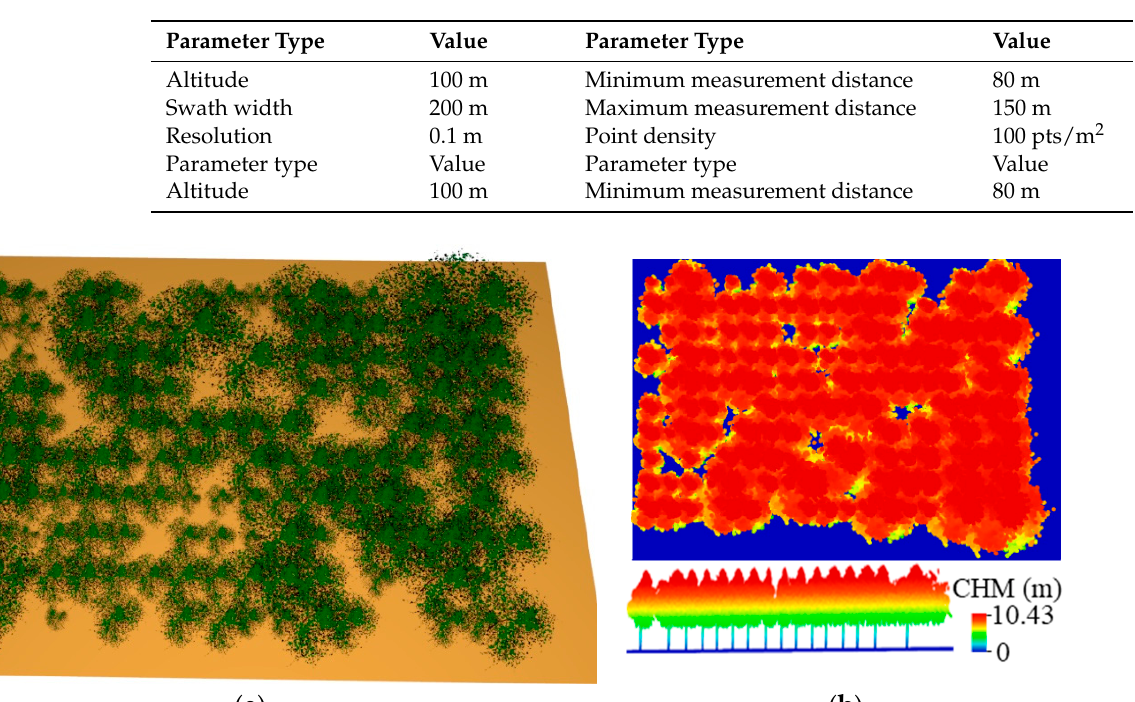
Table 3. Parameters for UAV LiDAR data simulation in the LESS model.